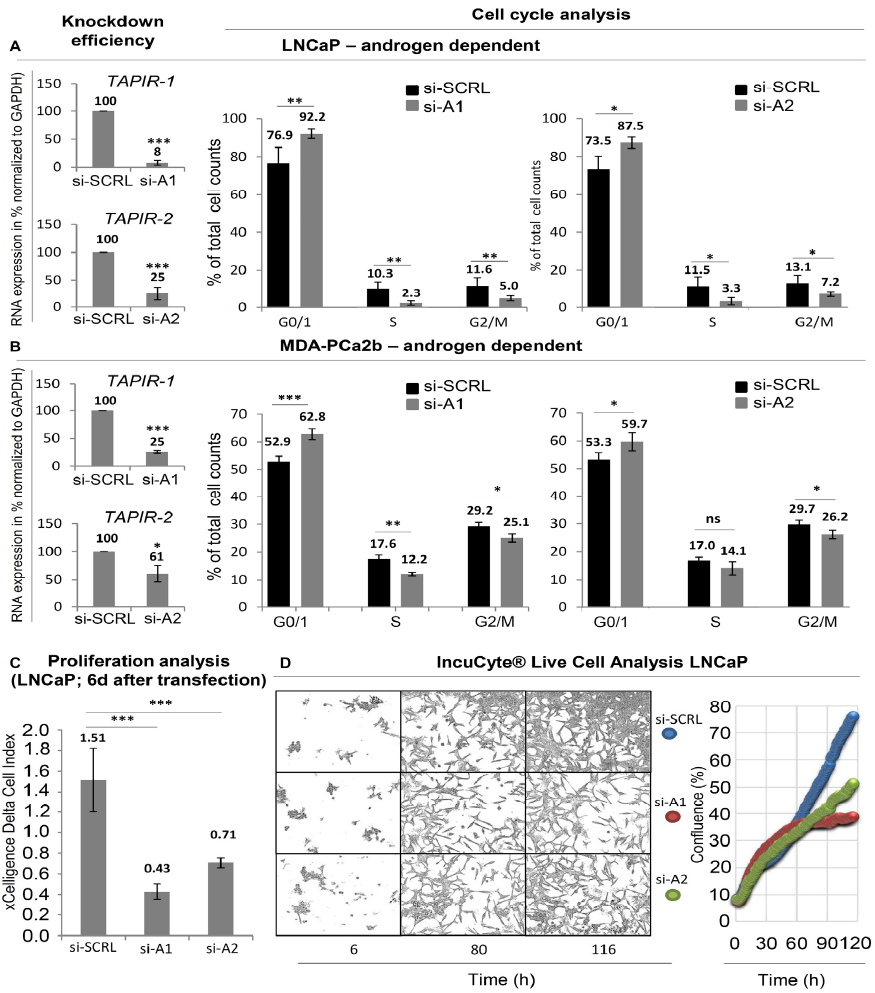
Figure 3. TAPIR transcript knockdown causes downregulation of cell cycle genes and growth arrest in PCa cells. ( A ) LNCaP and ( B ) MDA-PCa2b cells were cultured and treated with siRNA to knockdown TAPIR-1 and -2 . The knockdown e ffi cacy of siRNAs is shown 72 h after transfection. RNA was isolated from LNCaP and MDA-PCa2b cells and reverse transcribed into cDNA. The expression levels of TAPIR-1 and -2 were determined using qPCR and normalized to GAPDH . Data represent the mean ± s.d. of n = 3 biological replicates. Significance p ≤ 0.001 (***); student- t test. Cell cycle analysis was carried out after TAPIR knockdown. For cell cycle analysis, LNCaP and MDA-PCa2b cells were transfected with siRNAs against TAPIR-1 (si-A1), TAPIR-2 (si-A2) and a scrambled control (SCRL), fixed after 72 h and 120 h, DNA content labelled with propidium iodide and measured using flow cytometry. G0 / 1 phase arrest after TAPIR knockdown was observed. Data represent the mean ± s.d. of at least n = 4 biological replicates. Significance p ≤ 0.05 (*), p ≤ 0.01 (**); two-sided student- t test. ( C ) xCelligence real-time cell analysis (RTCA) proliferation analysis. The xCELLigence ® RTCA (Roche, Basel, Switzerland) instrument was used to non-invasively monitor cell status. SiRNA-transfected LNCaP cells were seeded and cultured in an electronic 96-well microtiter plate. The impedance value was measured and is plotted, which shows that as the cell index increases the cells proliferate. Data represent the mean ± s.d. of n = 3 biological replicates performed in technical quadruplicate. Significance p ≤ 0.001 (***); student- t test. ( D ) IncuCyte live cell analysis. LNCaP cells were siRNA-transfected and seeded into 96-well ImageLock plates. Cells were grown for six days and monitored using time-lapse microscopy hourly (representative images for 12 h, 60 h, and 116 h are shown). The results of the IncuCyte experiments were quantified using cell confluency and are shown by blue, red, and green filled circles indicating SCRL, si-A1, and si-A2,